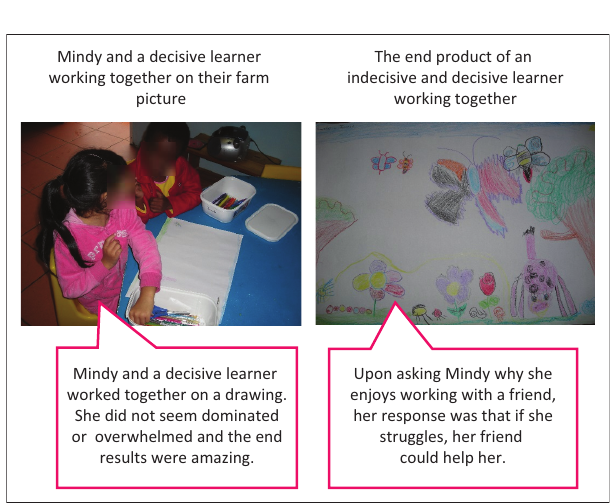
FIGURE 2: Mindy interacting with a decisive